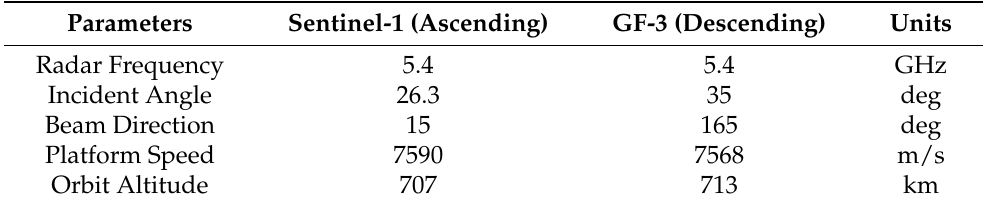
Table 1. Simulation